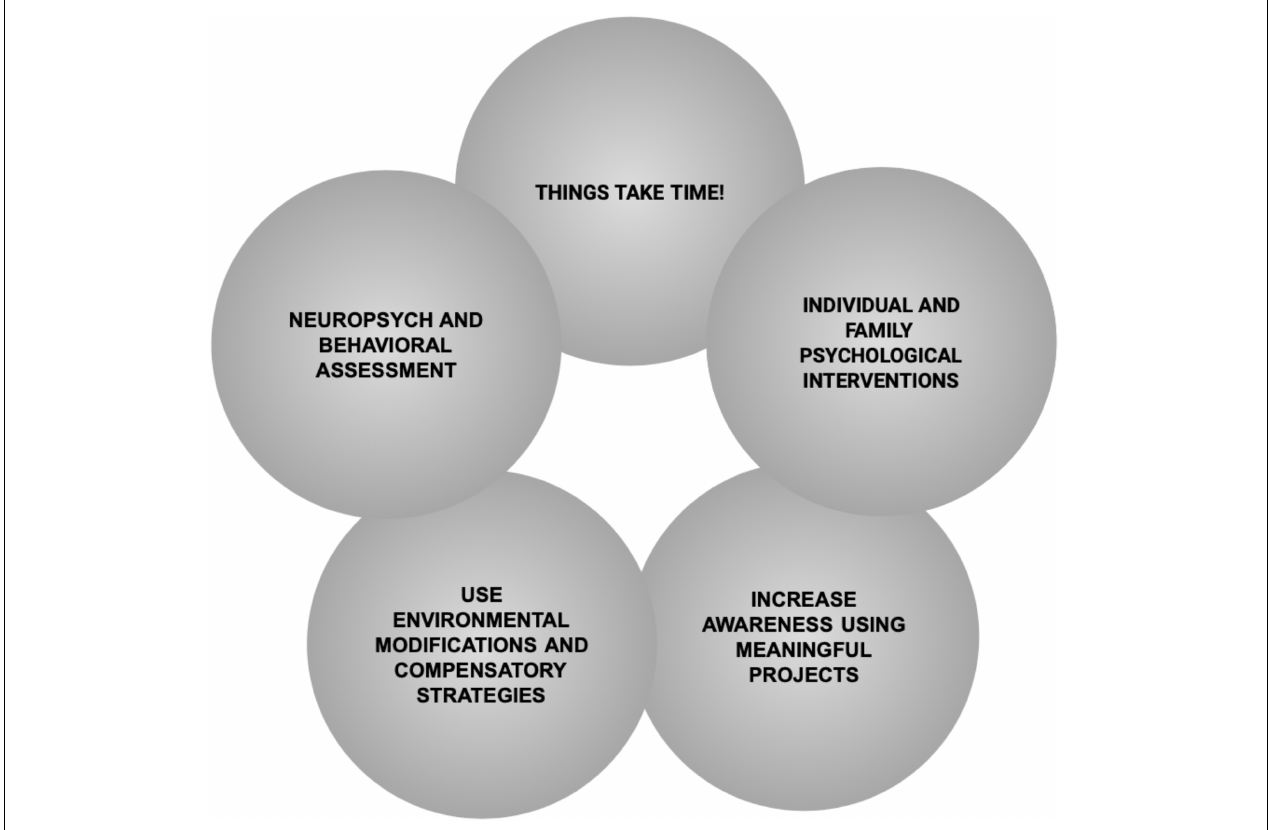
FIGURE 4 | Neuropsychological rehabilitation principles necessary to consider when working with ACoA stroke